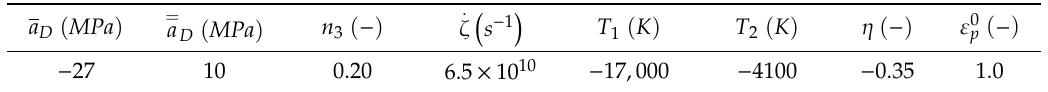
Table 2. Material parameters used in PM II for Q235B.